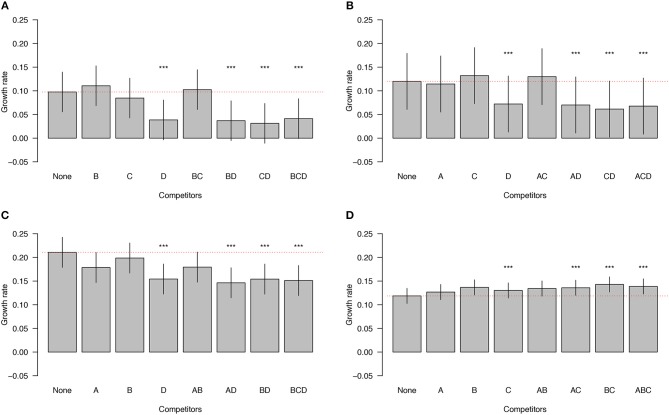
Impact of competitor subgroups on focal subgroup. The growth rates of subgroups A, B, and C are inhibited by the presence of subgroup D (A–C). In contrast, the growth rate of subgroup D is enhanced by the presence of the other subgroups (D). The identities of the competitors are indicated on the X axis. The red dotted line is the expected null growth rate (growth as a singleton). Growth rates above and below the red dotted line indicate facilitation and competition, respectively. Significant effects on growth rates of the focal subgroups in the presence of competitors are denoted by asterisks (***). The vertical lines on each bar indicate the 95% confidence intervals for the means.